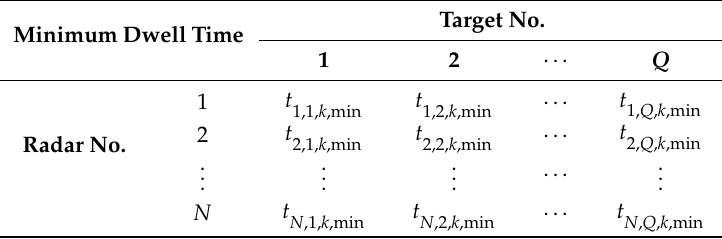
Table 1. Minimum dwell time